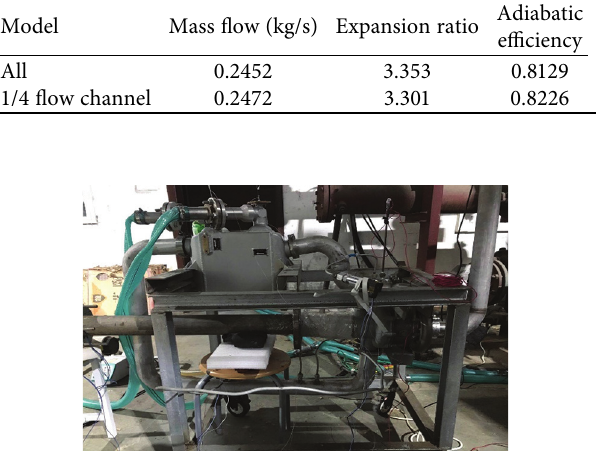
Figure 10: Power